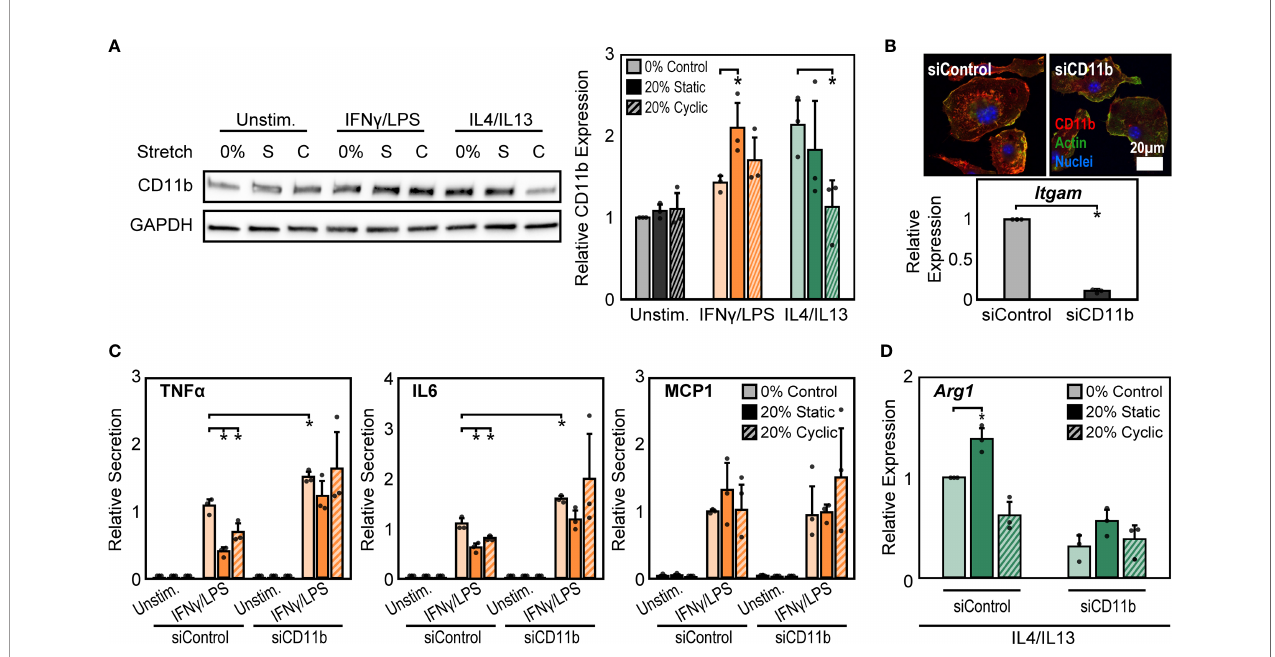
FIGURE 3 | CD11b is required for stretch-mediated changes in macrophage activation. (A) Representative Western blot of CD11b and GAPDH for unstimulated, IFN g /LPS, and IL4/IL13 stimulated macrophages exposed to 0% and 20% static and cyclic stretch (left). Quanti fi cation of average across three independent experiments for CD11b expression (right). Values were normalized to GAPDH and made relative to 0% stretch and unstimulated condition. (B) Representative immuno fl uorescence images (top) and quanti fi cation of relative Itgam gene expression in unstimulated macrophages treated with non-target (siControl) or CD11b (siCD11b) siRNA. Data relative to siControl condition. (C) Secretion of TNF a , IL6, and MCP1 for unstimulated and IFN g /LPS stimulated macrophages treated with siControl or siCD11b and exposed to either 0% control, 20% static, or 20% cyclic stretch. Data normalized to a siControl and IFN g /LPS treated internal control exposed to 0% stretch within each biological replicate. (D) Relative Arg1 gene expression in IL4/IL13 stimulated and siControl or siCD11b treated BMDMs exposed to 0% control, 20% static, or 20% cyclic stretch. Data relative to 0% siControl condition. Error bars indicate standard deviation of the mean for three separate experiments and * p < 0.05 when compared to the corresponding 0% stretch condition as determined by Student ’ s t-test (A, C) or paired t-test (B, D)